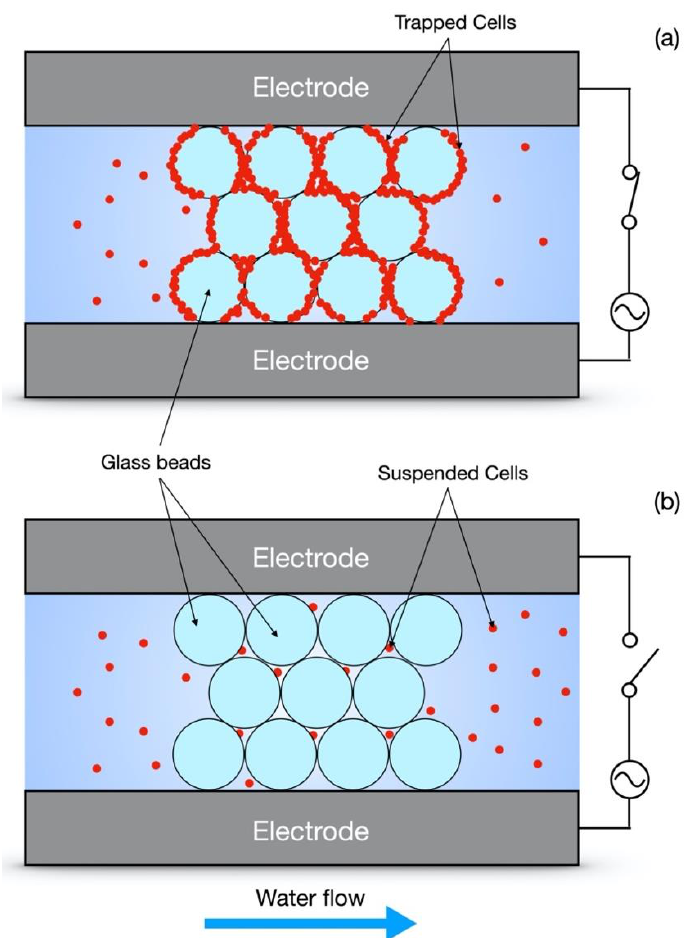
Figure 2. Basic principles behind the dielectric glass bead DEP device: ( a ) with voltage supplied to the electrodes, the cells attach to the surface of the electrodes when subject to positive-DEP forces; ( b ) without voltage supplied to the electrodes, the cells flow past the glass beads through the gap spaces and do not adhere to the beads (adapted from [38]).